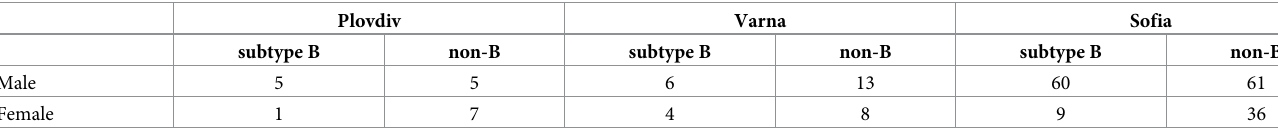
Table 3. Number of typeable participants with detected subtypes, by location and